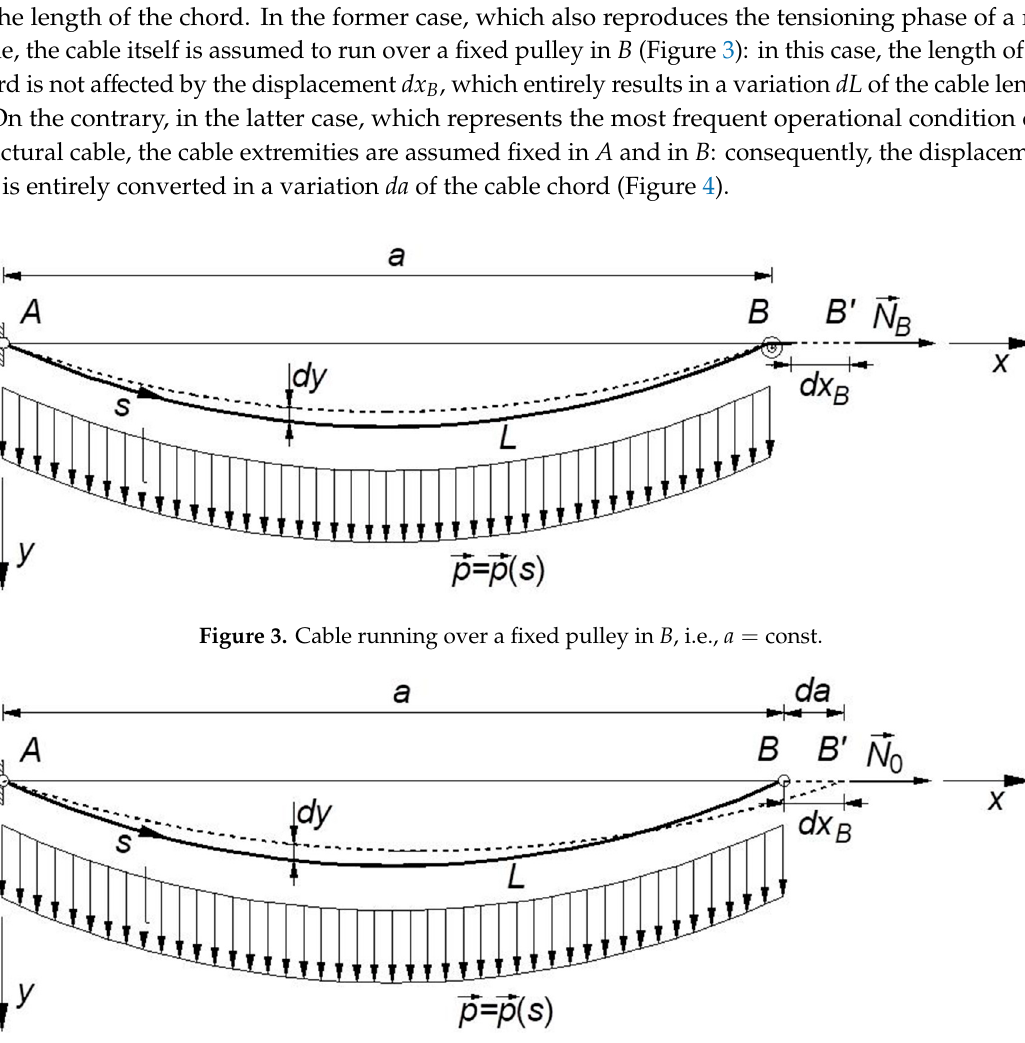
Figure 4. Cable with ends fixed in 𝐴 and in 𝐵 .